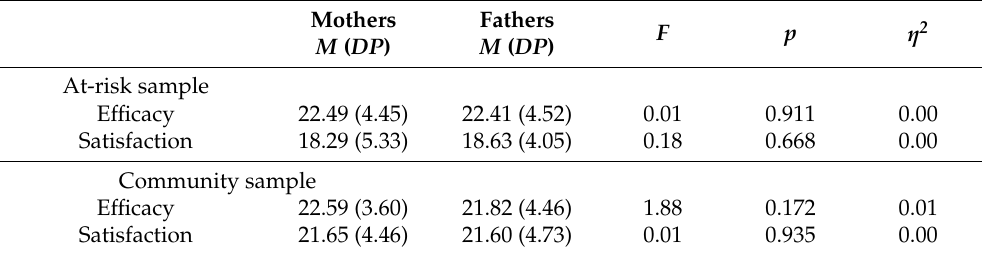
Table 7. Comparisons between mothers’ (N = 309) and fathers’ (N = 144) in PSOC scores.